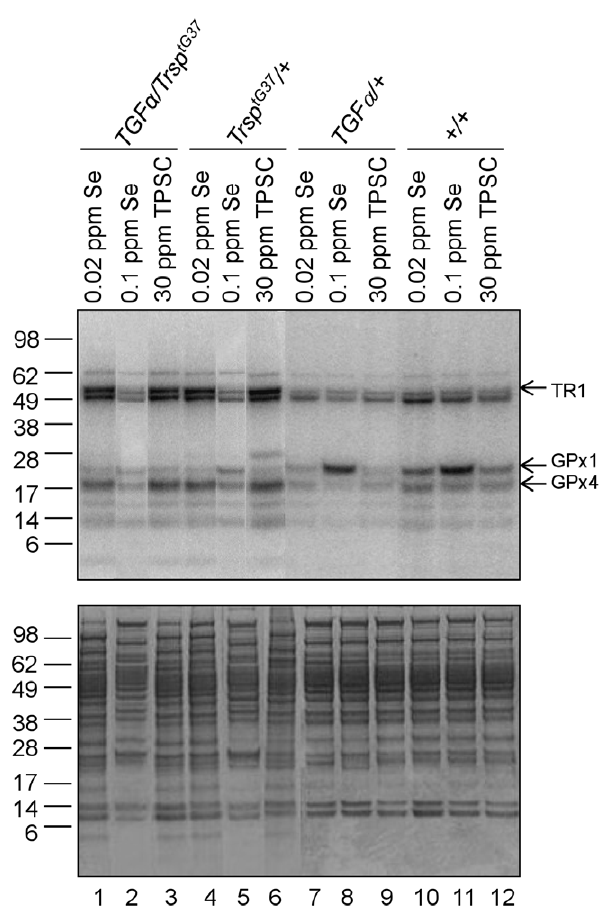
Figure 5. Labeling of selenoproteins in liver. Mice were labeled with 75 Se, protein extracts prepared, aliquots of the extracts electro- phoresed on denaturing gels, the developed gels stained with Coomassie Blue to use as a loading control (lower panel) and 75 Se- labeled selenoproteins detected using a PhosphorImager (upper panel). Molecular weights of proteins are indicated on the left of the panels and selenoprotein identity by arrows on the right of the upper panel. Details of the procedures are described in Materials and